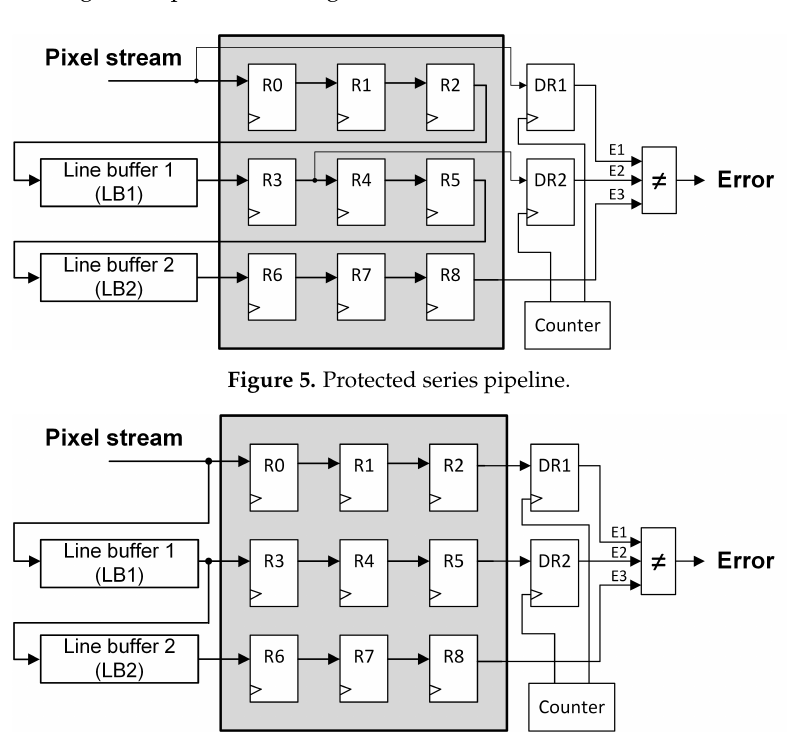
Figure 6. Protected parallel